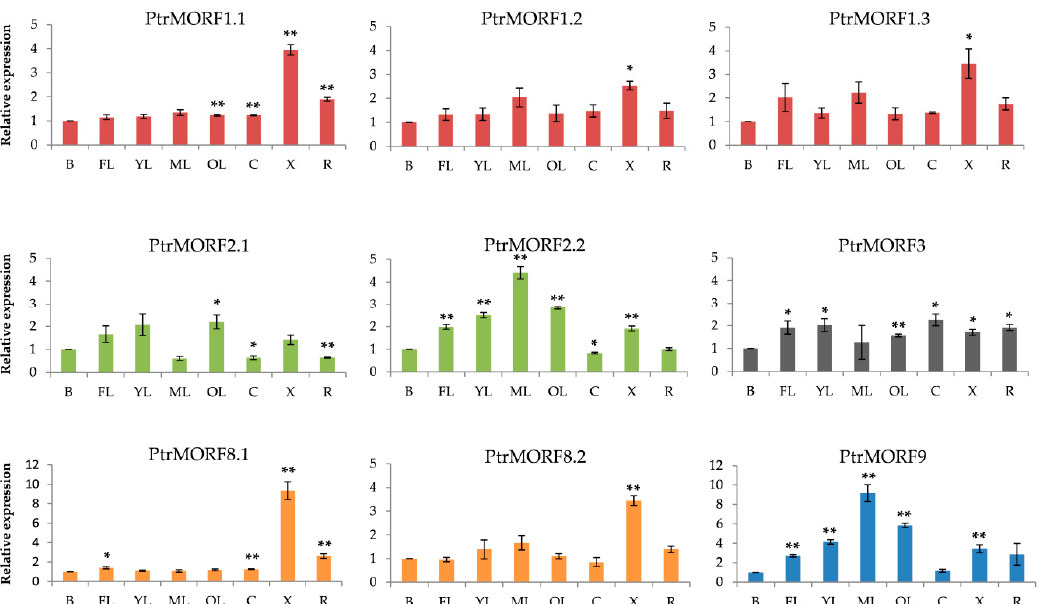
Figure 9. Expression analysis of 9 MORF genes in eight representative samples by qRT-PCR. Eight various tissues including buds (B), freshly expanded leaves (FL), expanding young leaves (YL), mature leaves (ML), old leaves (OL), cortex (C), xylem (X), and roots (R). Data were normalized to UBQ gene. The buds were defined as 1 in the figure. The data were presented as the mean ± SE of three separate measurements. Asterisks denote significant differences: * p < 0.05; ** p <